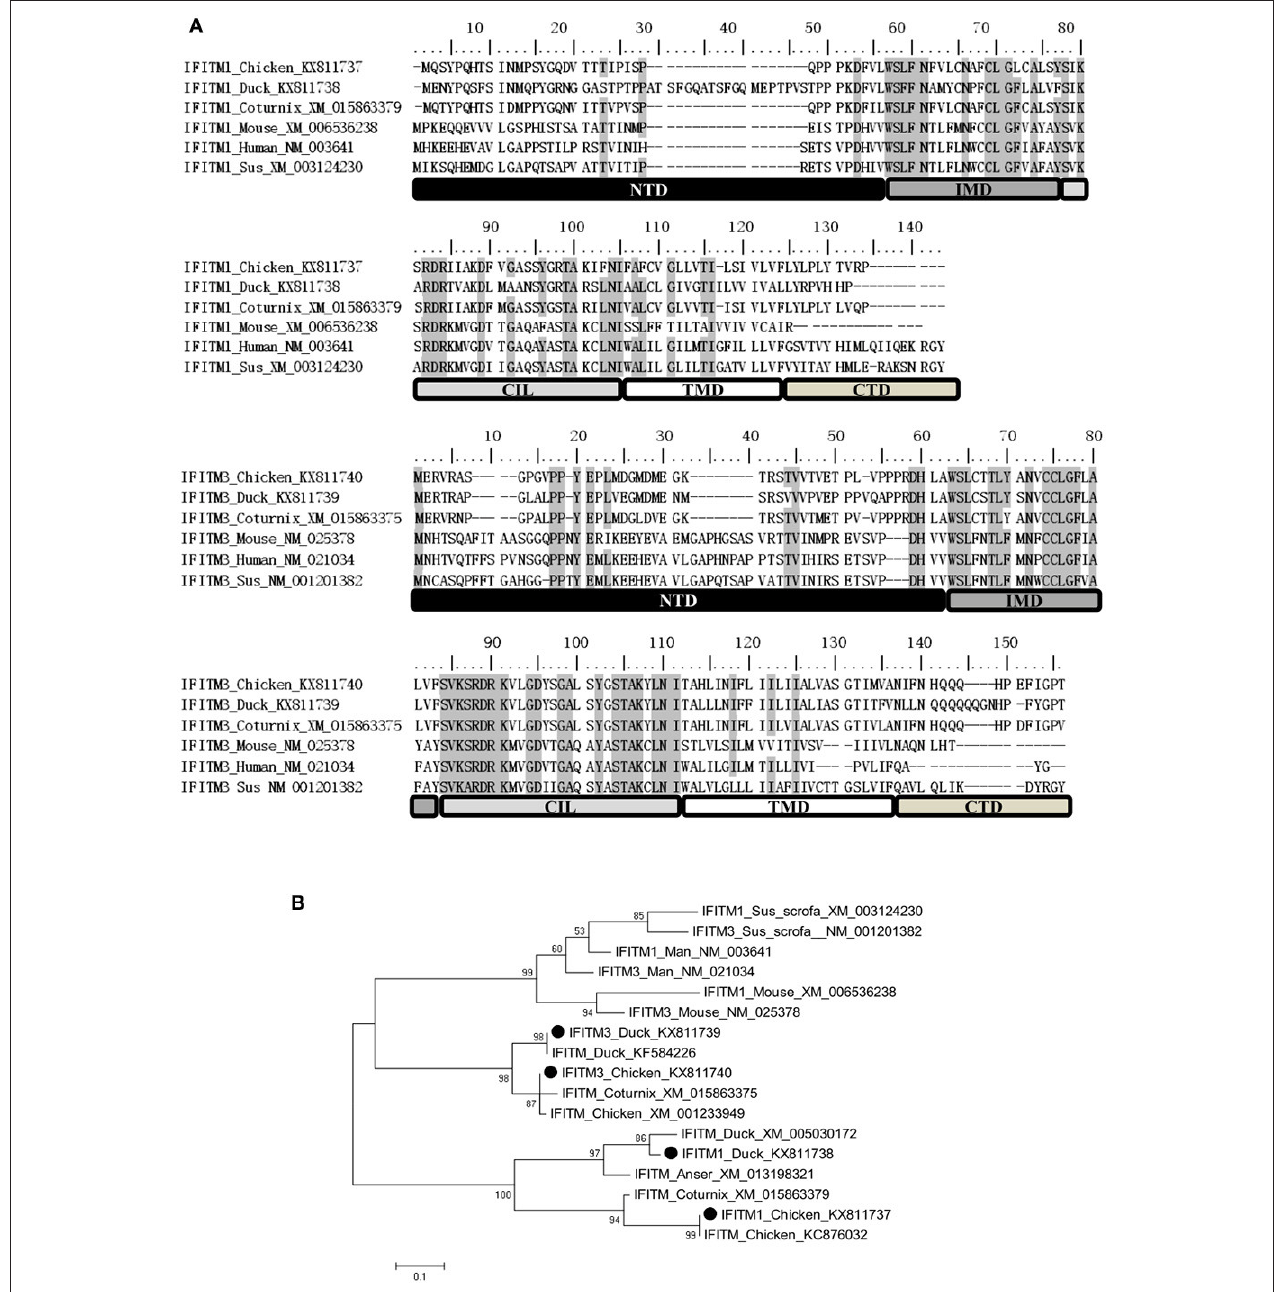
FIGURE 7 | Analysis of chicken and duck IFITM1 and IFITM3 proteins. (A) IFITM sequences were aligned using MUSCLE software. Five domains in each sequence alignment were highlighted with different colors: N-terminal domain (NTD), intramembrane domain (IMD), conserved intracellular loop (CIL), transmembrane domain (TMD), and C-terminal domain (CTD). Gray background indicated amino acid identity. (B) A maximum-likelihood tree was generated between chicken/duck IFITM1, 3 amino acid sequences, and other species using MEGA 5.0 software. Bootstrap analysis was performed with 1000 trials. Black circle ( • ):